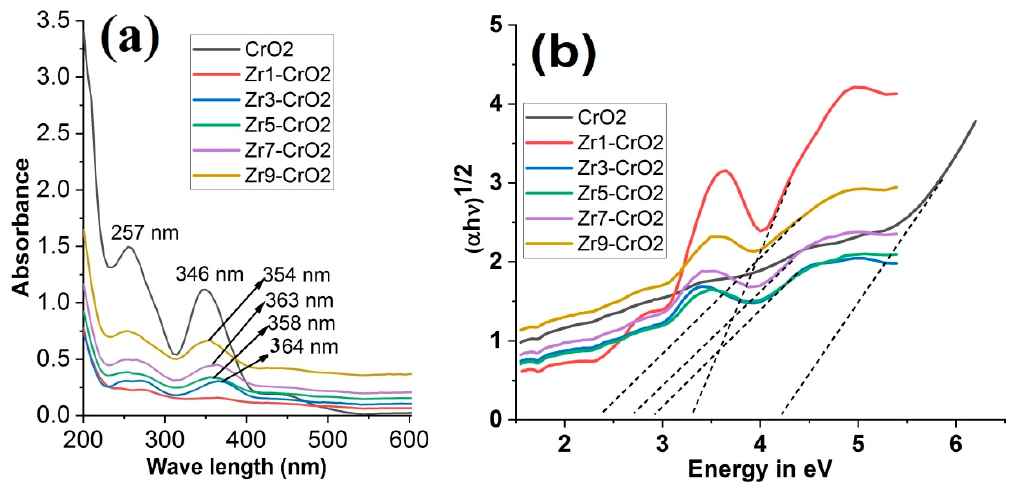
Figure 5. ( a ) UV ‐ Vis spectra; ( b ) Band gaps of Zr ‐ doped CrO 2 photocatalysts. Figure 5. ( a ) UV-Vis spectra; ( b ) Band gaps of Zr-doped CrO 2